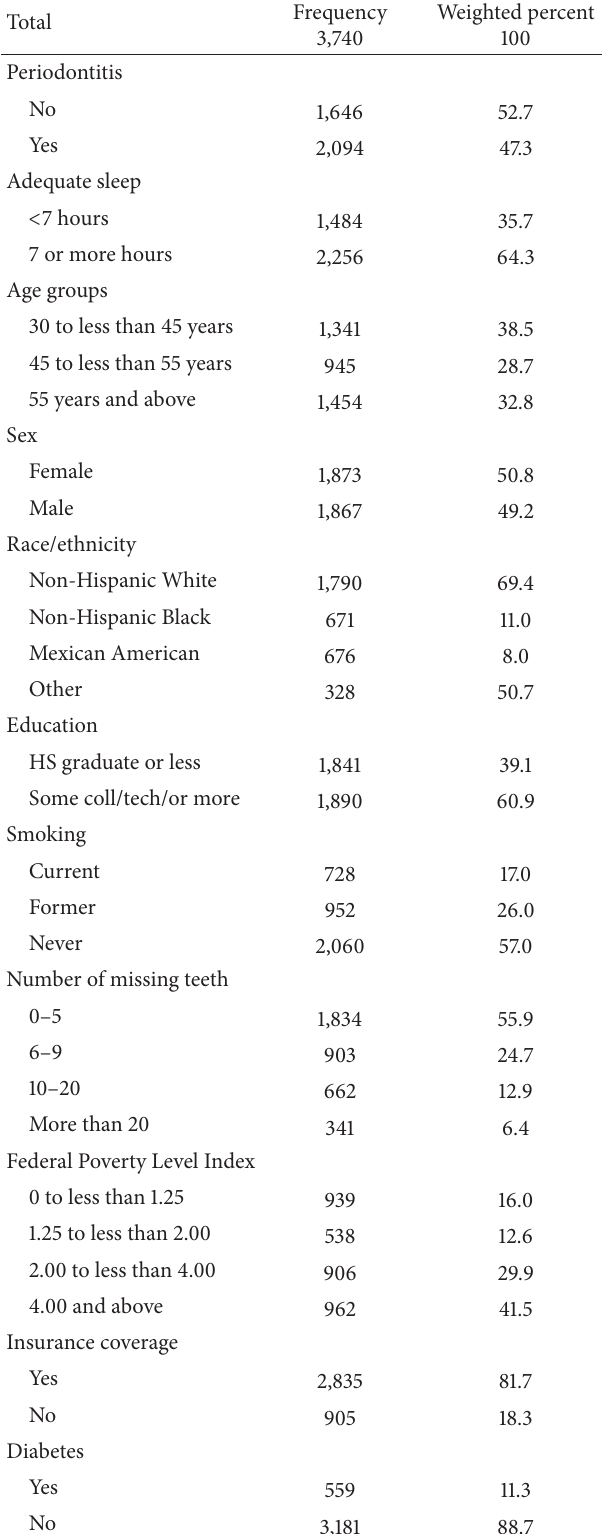
Table 1: Sample characteristics: NHANES Health and Nutrition Examination Surveys